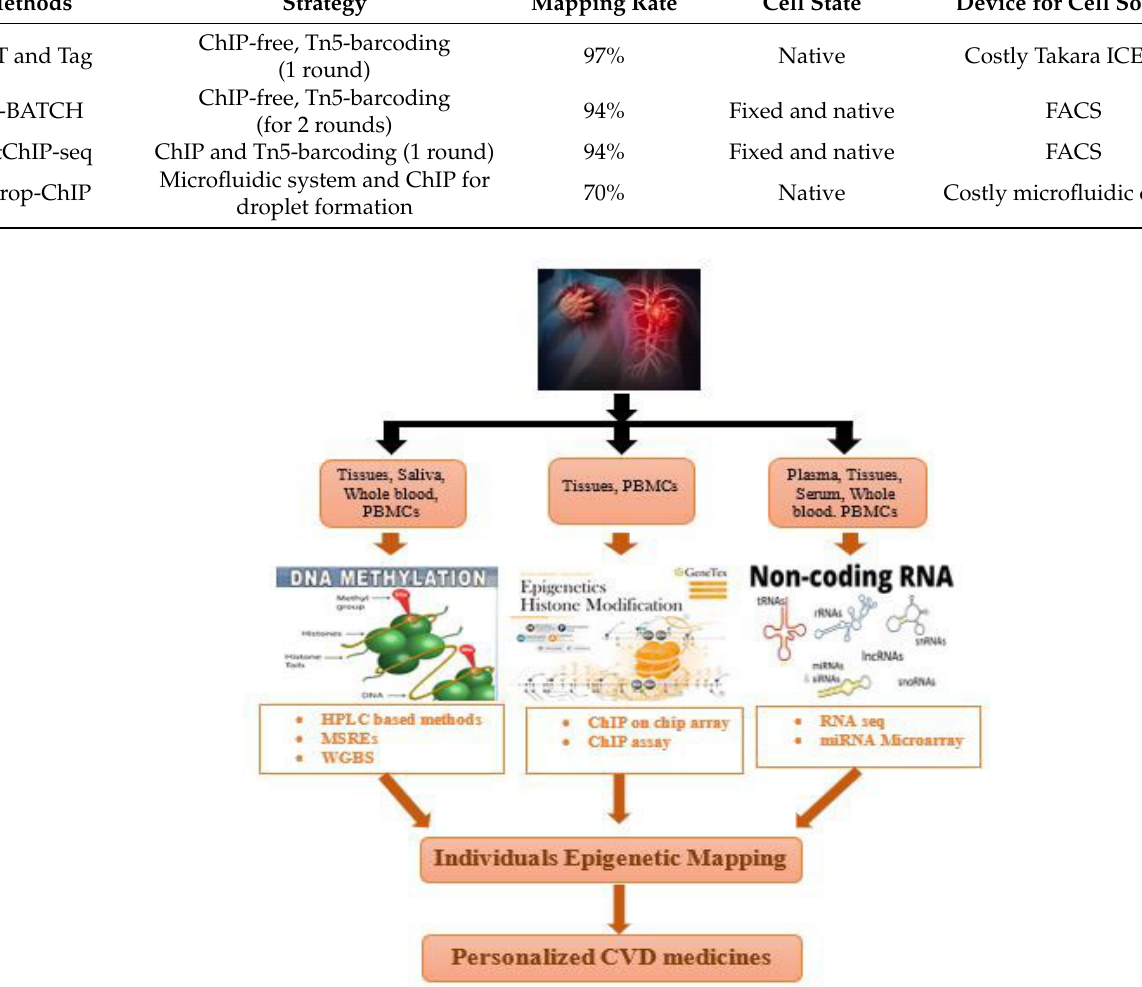
Figure 3. Application of epigenetic mapping techniques for CVD patients.